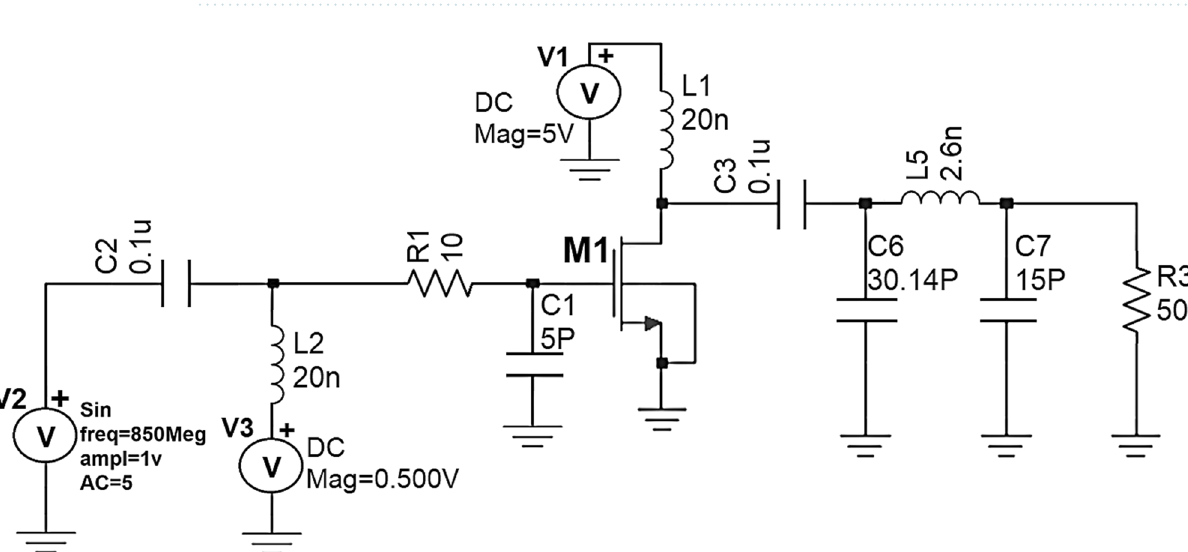
Figure 9. The schematic circuit of Class-J PA with a sinusoidal input source at 850